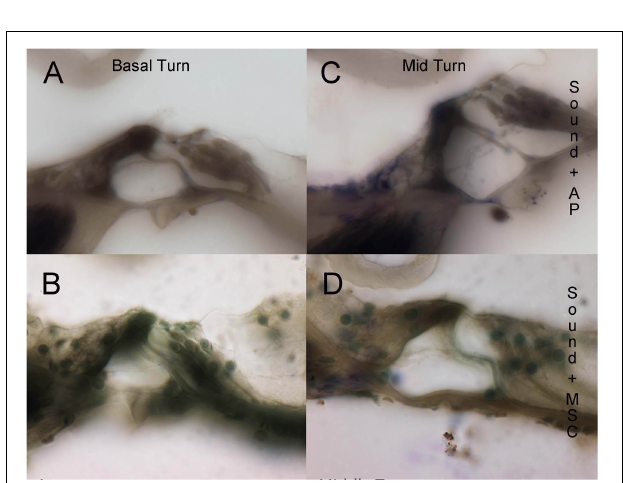
FIGURE 3 | Histological evaluation of organ of Corti integrity in sound trauma (A,C) and sound trauma and MSC (B,D) treated cochlea. Loss of inner hair cells is consistently seen in the basal turns of both groups (A,B) . The MSC treated group showed occasional survival of inner hair cells at the midturn